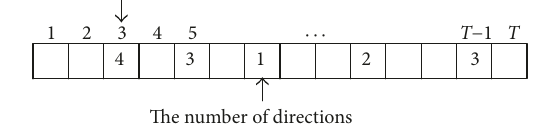
Figure 3: Schematic diagram of chromosome